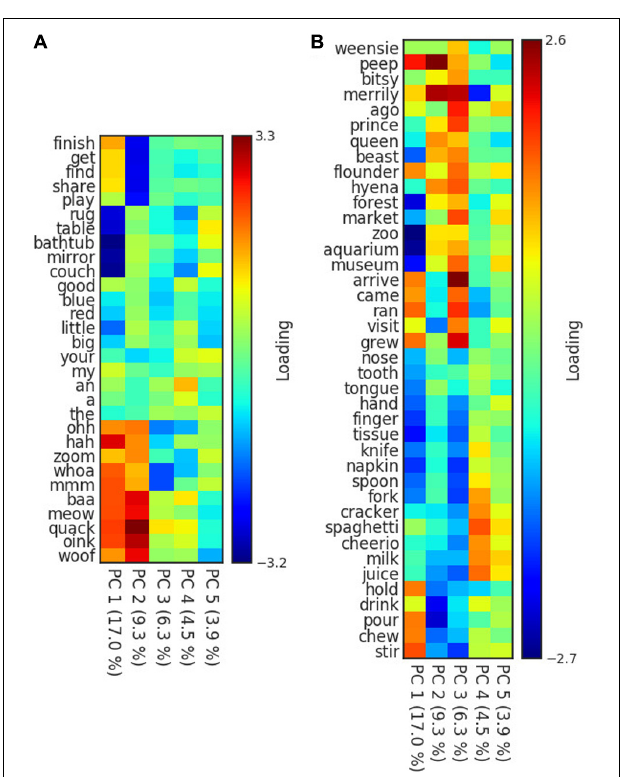
FIGURE 3 | Heatmap of principal component loadings of words grouped by (A) grammatical category, and (B) activity context. Principal Components Analysis was computed using hidden layer activations learned by the